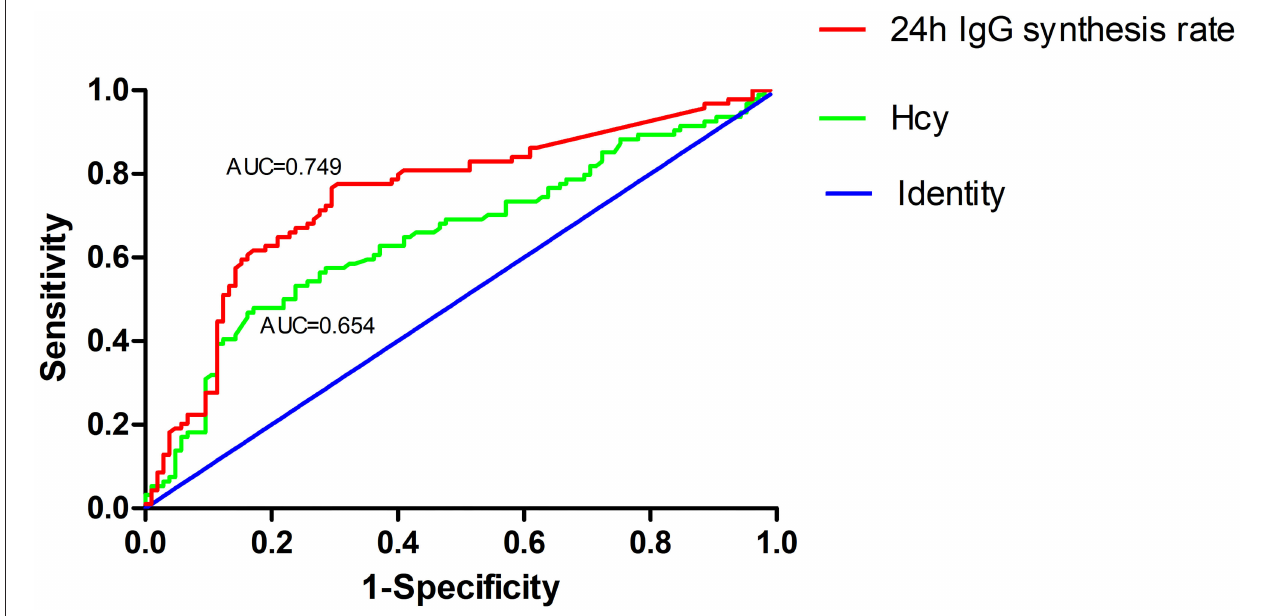
FIGURE 4 | Receiver operating characteristic (ROC) curve showing the predictive ability of Hcy and 24h IgG synthesis rate for highly active NMOSD. The area under the ROC curve was 0.654 and 0.749 for Hcy levels and 24h IgG synthesis rates,